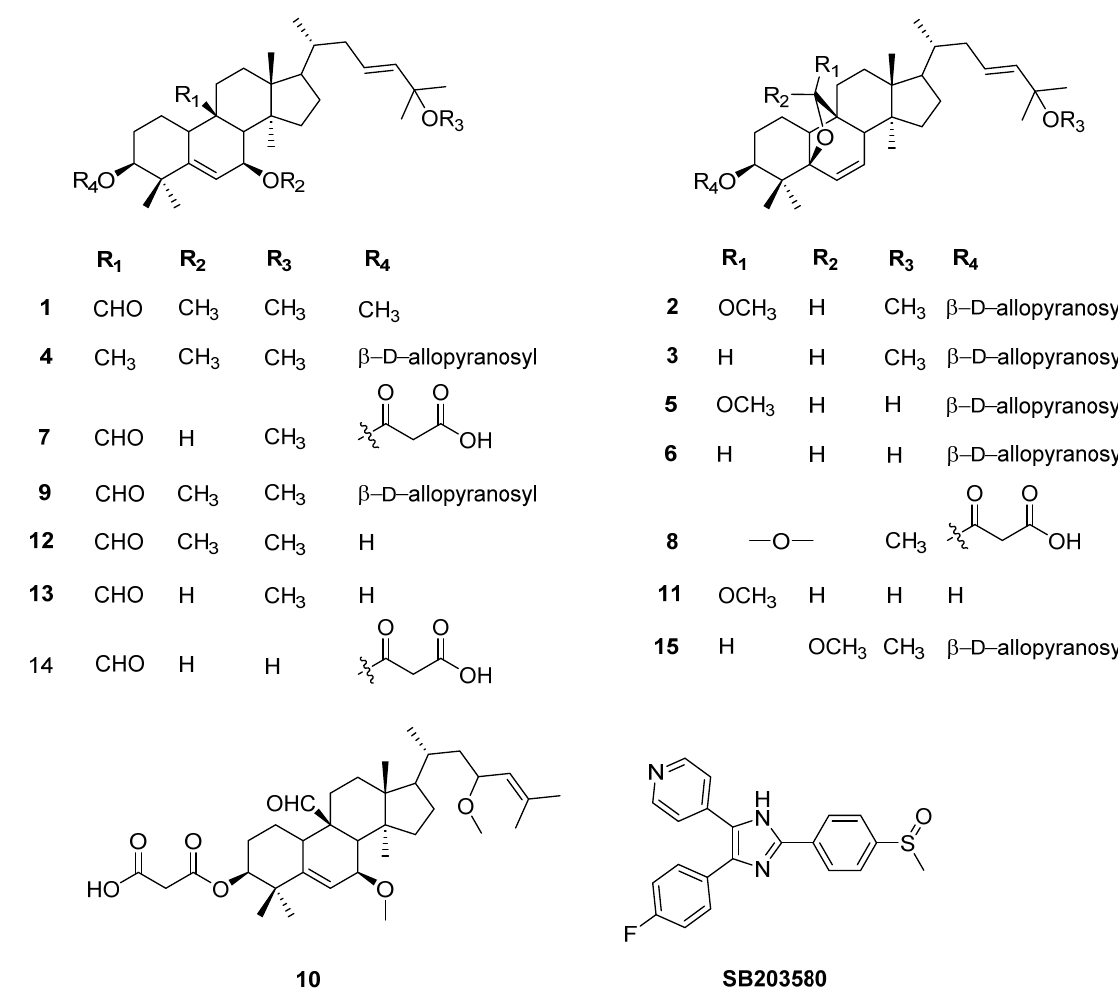
Figure 1. The isolated compounds from M. charantia ( 1 – 15 ) and SB203580